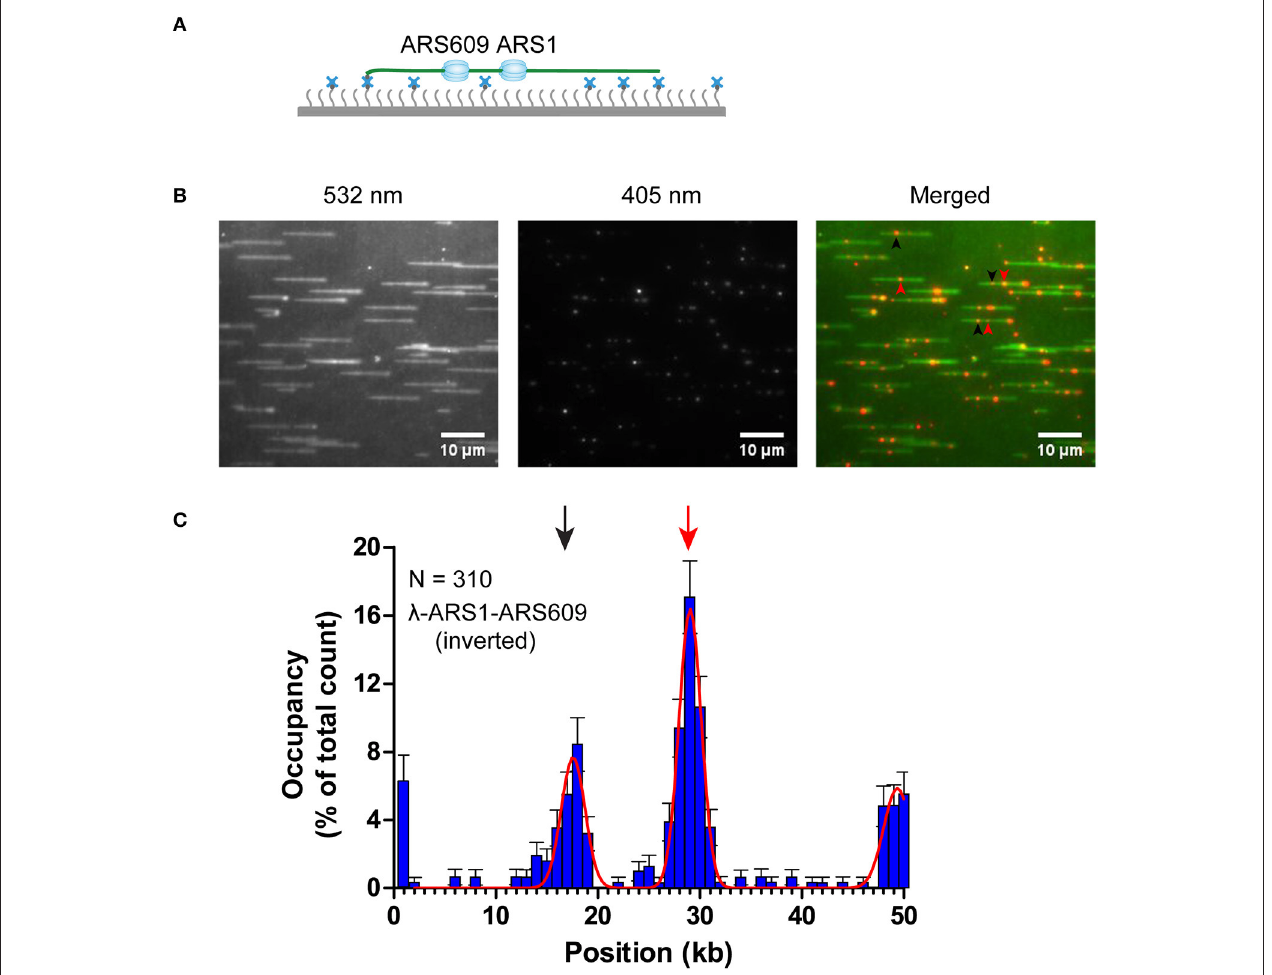
FIGURE 6 | ORC binding on inverted λ -ARS1-ARS609. (A) ORC binding on inverted λ -ARS1-ARS609 together with flow in theory. DNA was biotinylated using the biotinylated oligonucleotide complementary to the right end of native λ DNA. (B) ORC-Qdot 705 binding on inverted λ -ARS1-ARS609. (left) DNA was stained using SYTOX Orange and excited using a 532nm laser; (center) ORC-Qdot 705 was excited using a 405nm laser; (right) merged images. Three ORC binding positions at ARS1 and ARS609 are indicated by red and black arrows, respectively. (C) Distribution of ORC binding on inverted λ -ARS1-ARS609. Positions of ARS1 and ARS609 inserted sites are indicated by red and black arrows,